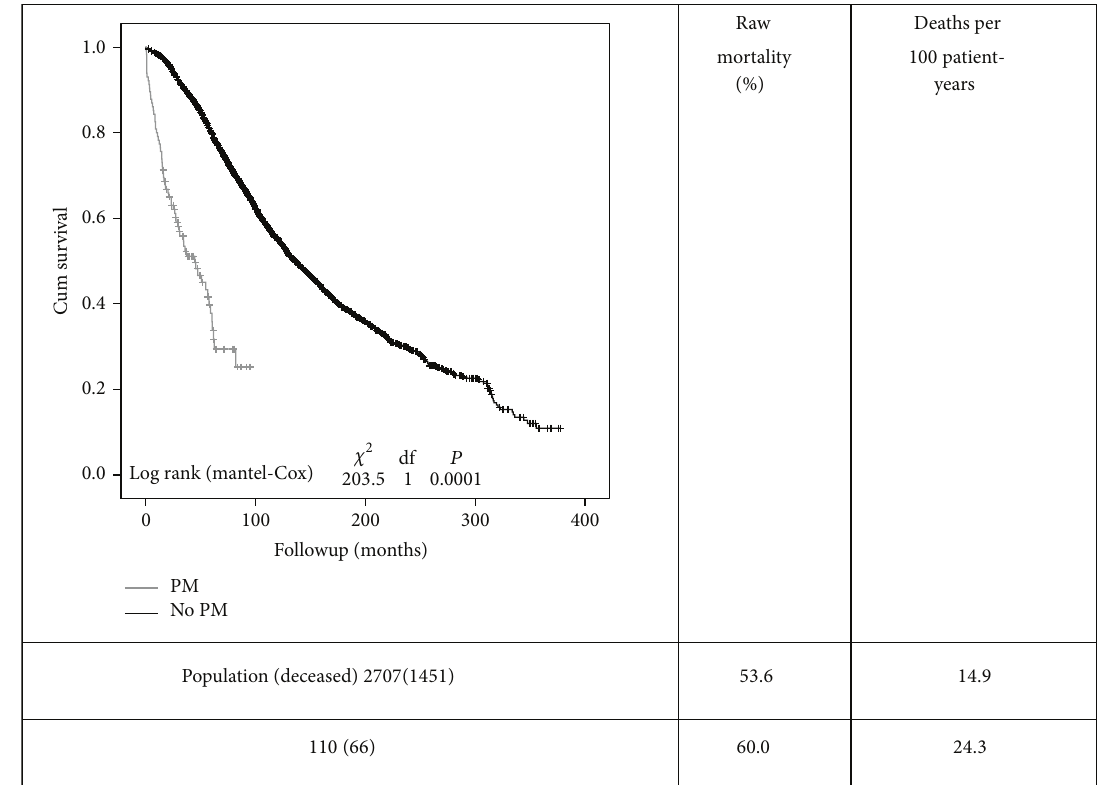
Figure 2: Kaplan-Meier survival curves comparing both groups (PM-pacemaker grey line and non-PM black line). Curves are quite different and show a high mortality in both groups, particularly in the PM group. Mortality (raw and adjusted) rates are shown on the right side of the